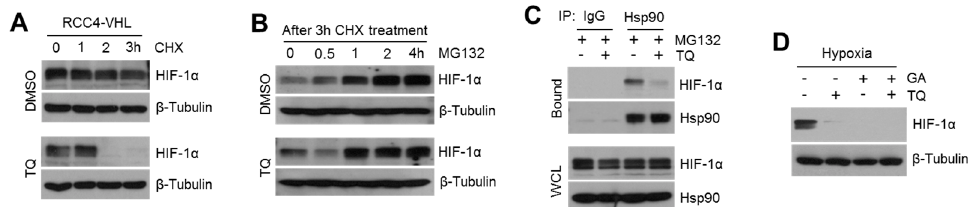
Figure 4. TQ causes rapid degradation of HIF-1 α by inhibiting interaction between HIF-1 α and HSP90. ( A ) VHL-null RCC4 cells were incubated with 100 µ M of CHX for 0, 1, 2, or 3 h in the absence